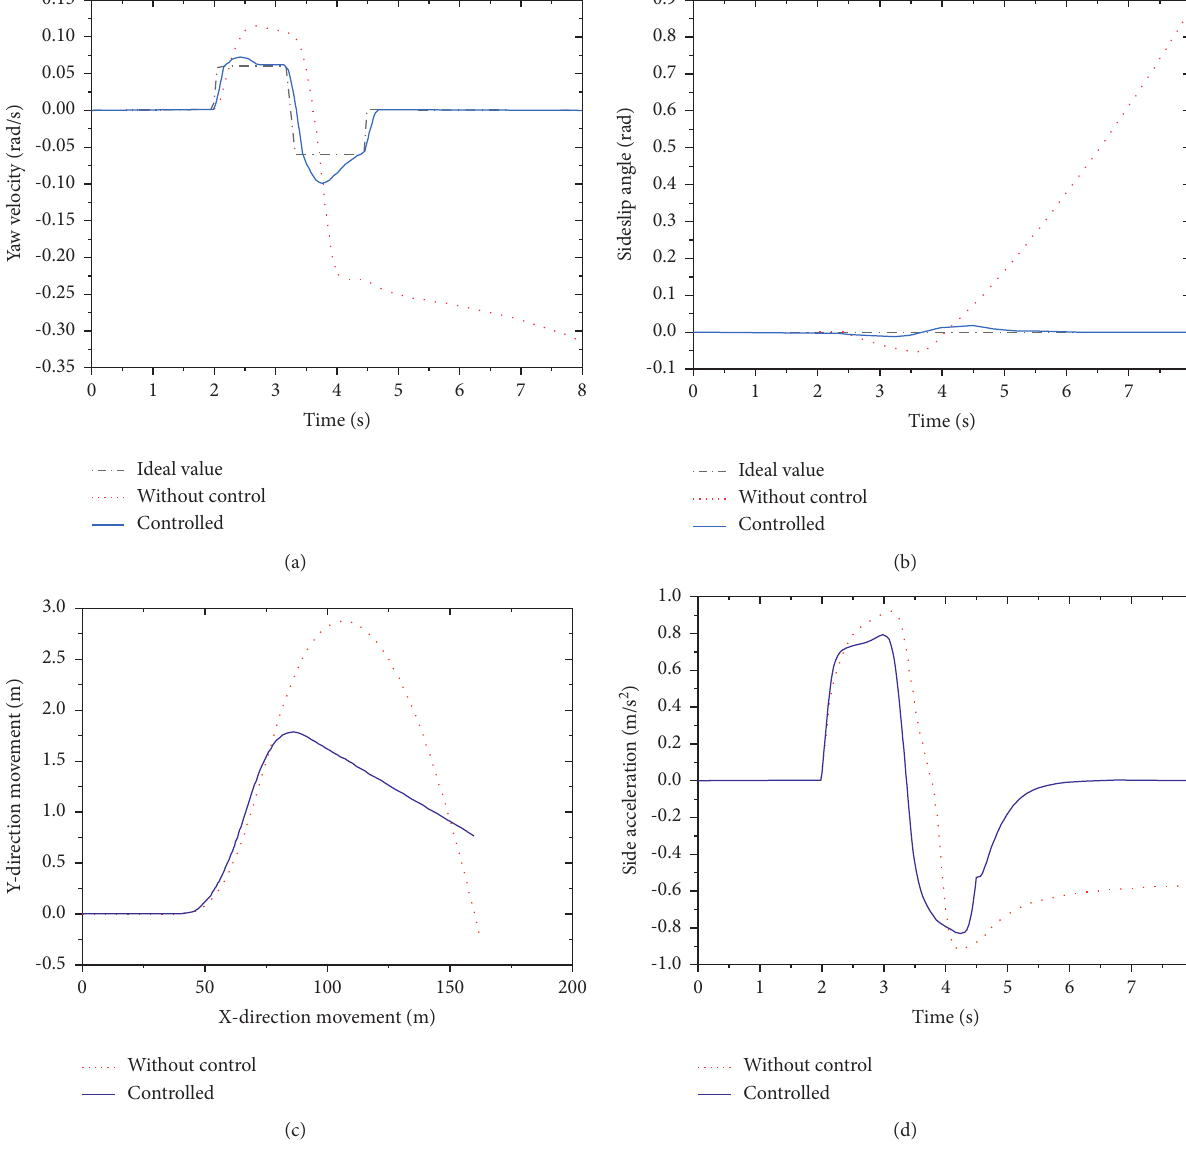
Figure 7: Simulation results of single lane change at an initial velocity of 50km/h. (a) Change in yaw velocity. (b) Changes in sideslip angle. (c) Vehicle trajectory. (d) Change in lateral